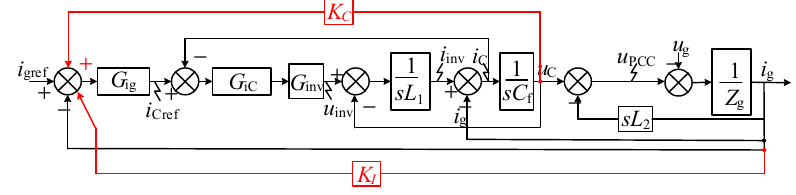
Figure 10. The structure of capacitor voltage and grid-side inductor voltage feedback control loop.